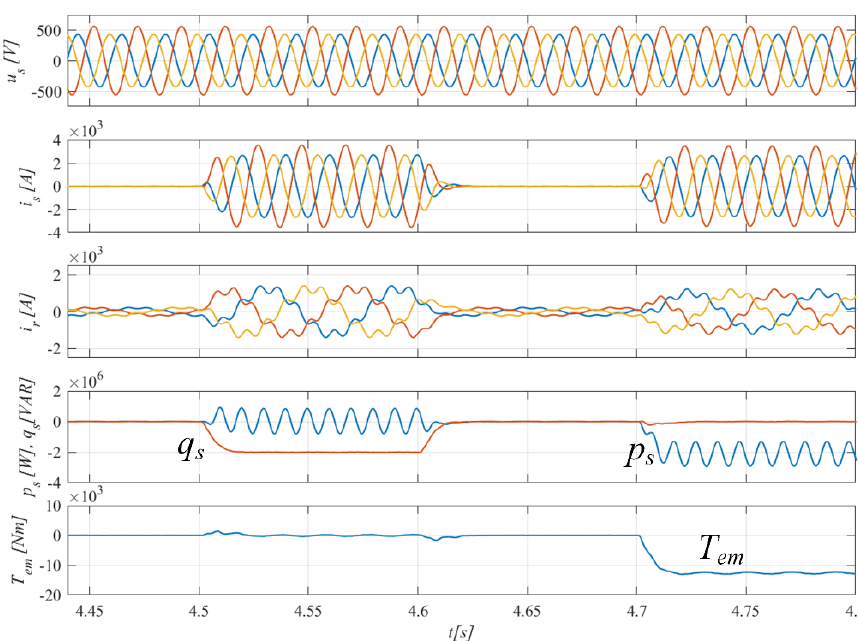
Figure 11. Simulation results of DPC in case of asymmetrical grid voltage with the feedforward and decoupling mechanism and with stator power calculated with consideration of rotor current.